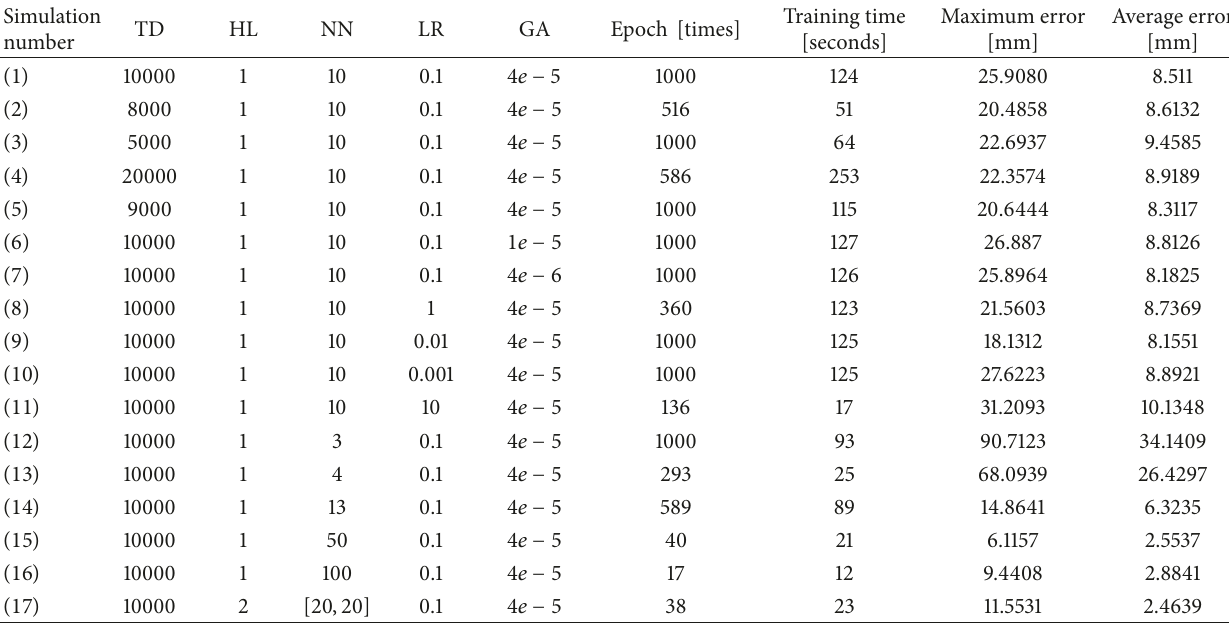
Table 2: Simulation results of different parameters of BPNN for the